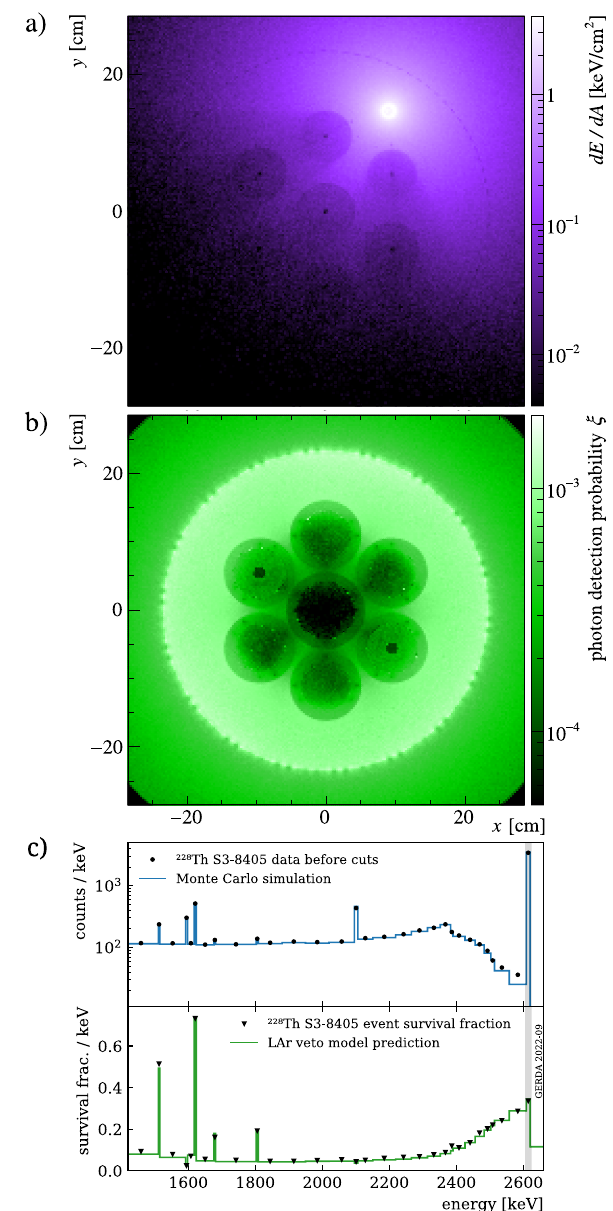
Fig. 5 Data/Monte Carlo comparison. a Projected distribution of the LArenergydepositionsforsimulated 208 Tl2615keVFEP-eventsfroma calibrationsourceatposition8405mm.Darkercirclescorrespondtothe volumeoccupiedbytheHPGedetectors. b Photondetectionprobability ξ in the same region. c Top panel: the energy spectrum of the 228 Th data corresponding to figure a , before the LAr veto cut, compared to the Monte Carlo prediction. The pdf is normalized to reproduce the total count rate in data. Despite small shape discrepancies, the predicted LAr veto survival probability (bottom panel) matches the data over a wide range of energies, even far from the model optimization energy region (gray band). A variable binning is adopted for visualization purposes